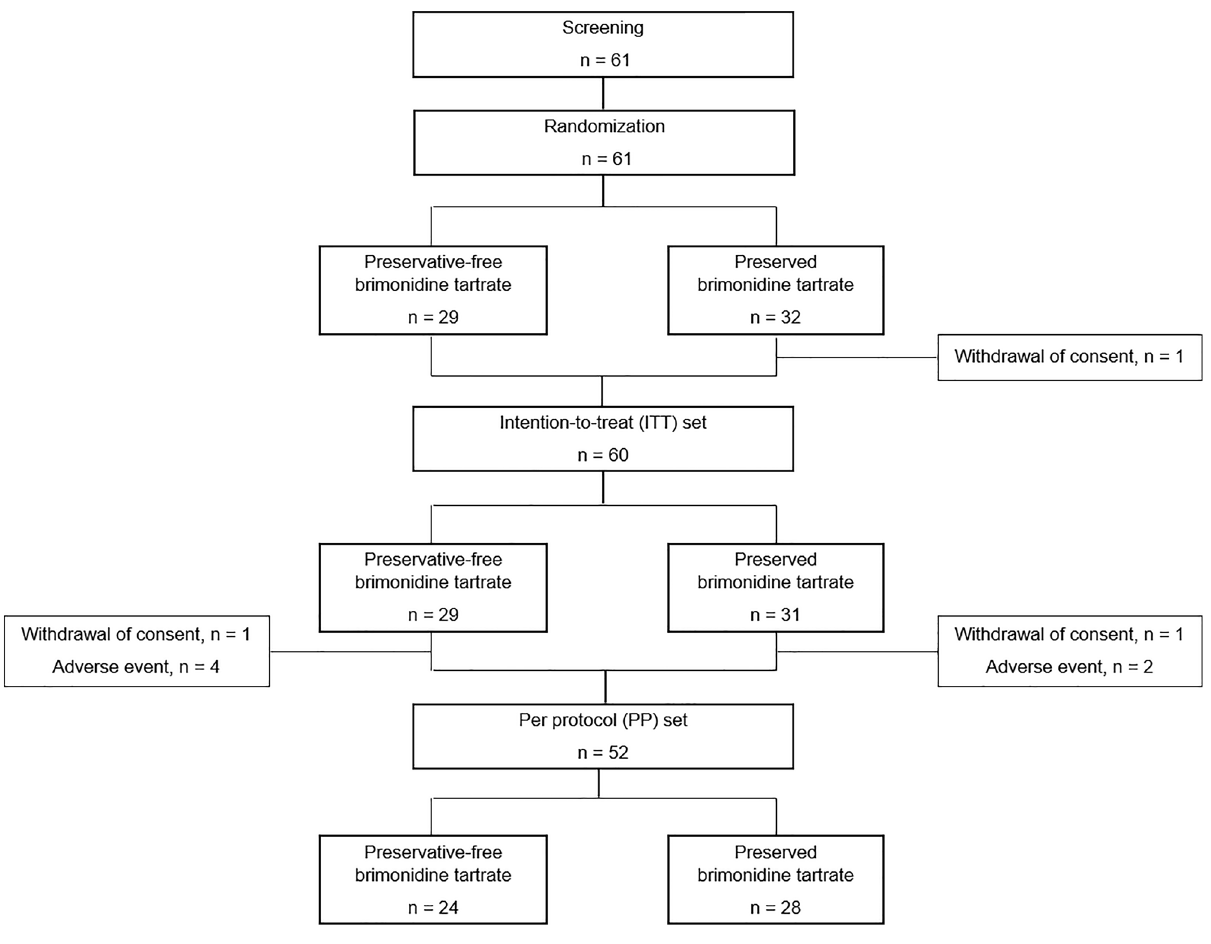
Figure 1. Flow chart of subject